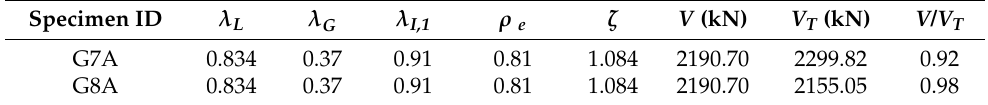
Table A14. Analysis results of test specimens reported by Driver et al. [5].